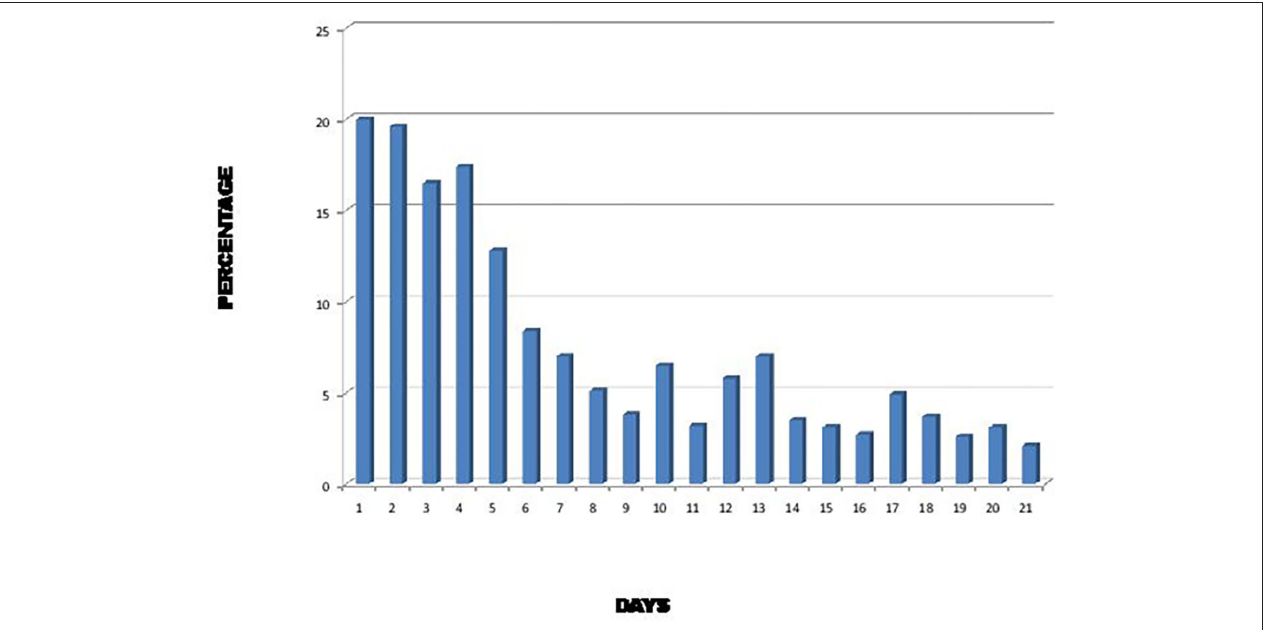
FIGURE 1 | Percentage of SARS patients with diarrhea during the first 21 days of illness (16).